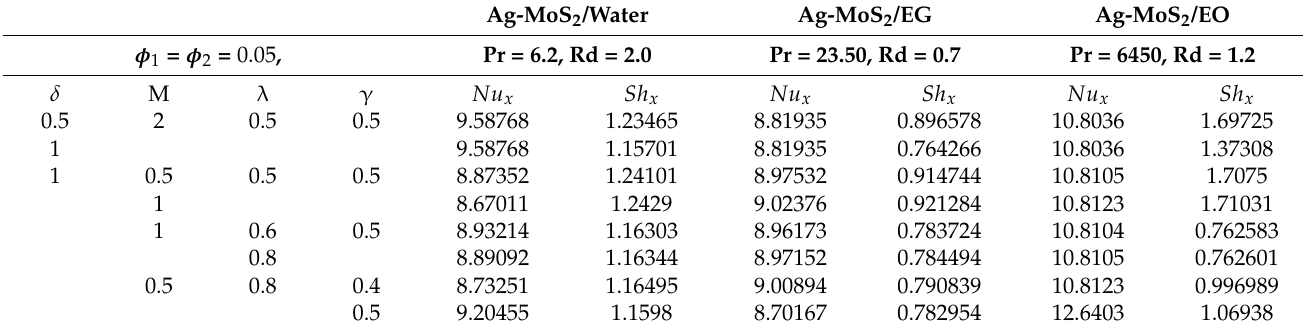
Table 2. The Nusselt and Sherwood number (N u x , Sh x ) results for the Ag-MoS 2 /H 2 O, Ag-MoS 2 /EO, Ag-MoS 2 /EG hybrid